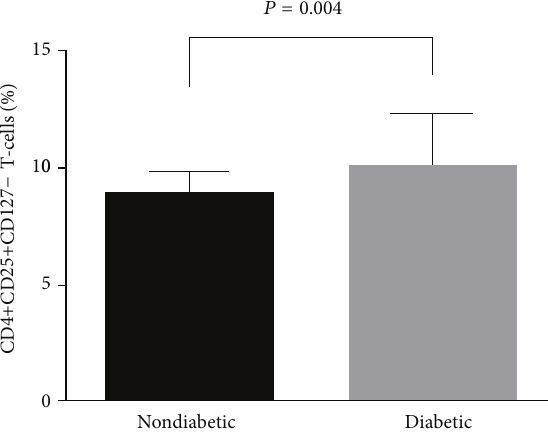
Figure 3: Comparative analysis of frequencies of CD4+CD25+CD127 − T-cells in healthy children and T1D children. Bars represent medians while whiskers represent interquartile